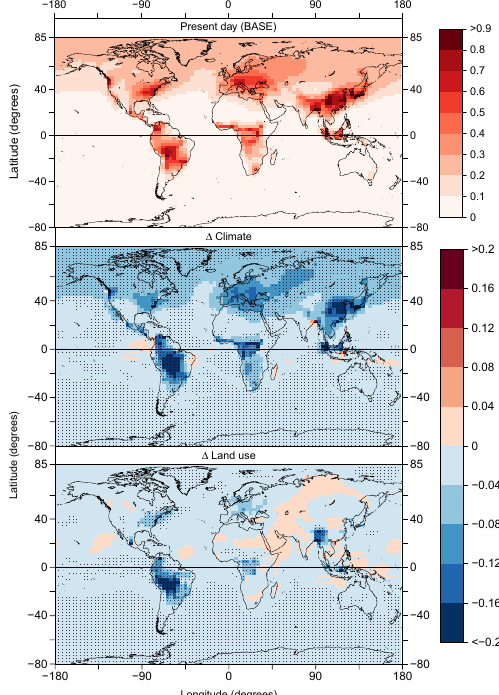
Fig. 6. Five-year mean near-surface ( < 720m) PAN (ppb) in (a) BASE. (b–c) give the change in PAN due to (b) climate and (c) land use between future and present-day (2095–2000). The changes in (b–c) are considered significant (stippled) if they are greater than 2 times the standard deviation for the five year mean (i.e. approximately the 5 % level).